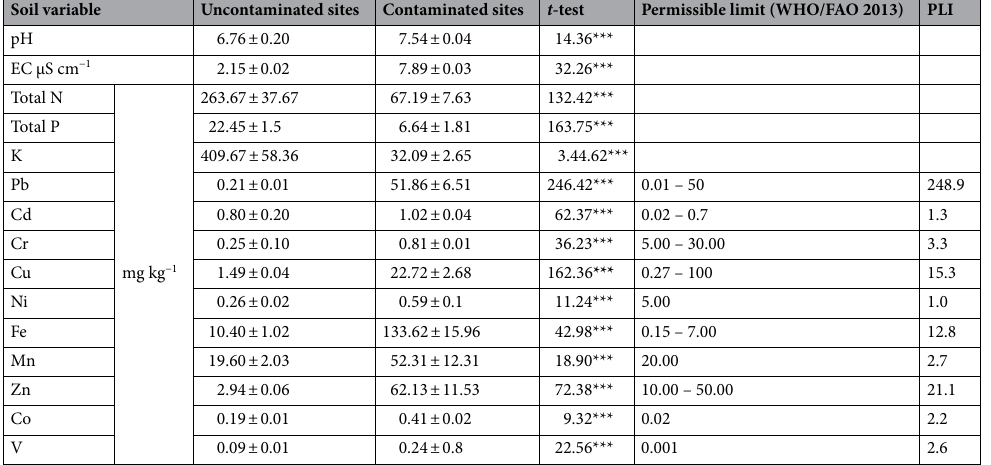
Table 1. Chemical characteristics (Mean ± SD) of contaminated and uncontaminated eggplant soils ( N = 18 ). ***: p <